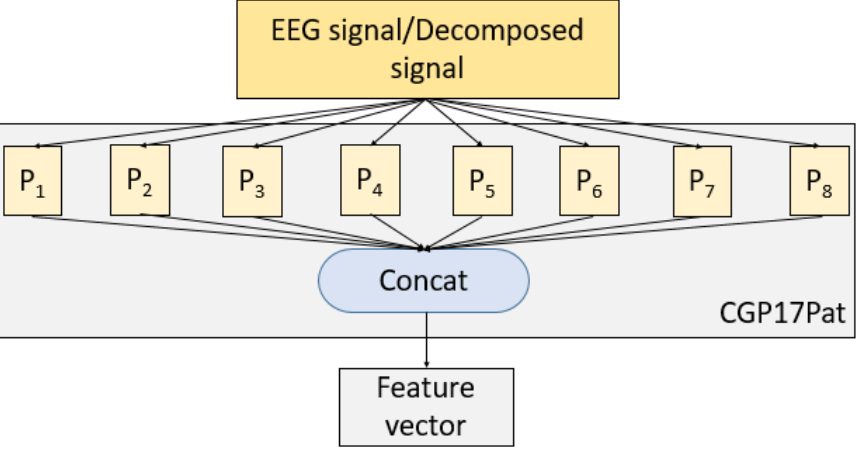
Figure 3. The graphical summarization of the presented CGP17Pat. Here, P denotes patterns (see Table 2), and each pattern extracts 256 features. Then, these feature vectors are merged, and 2048 (=256 × 8) features are created.